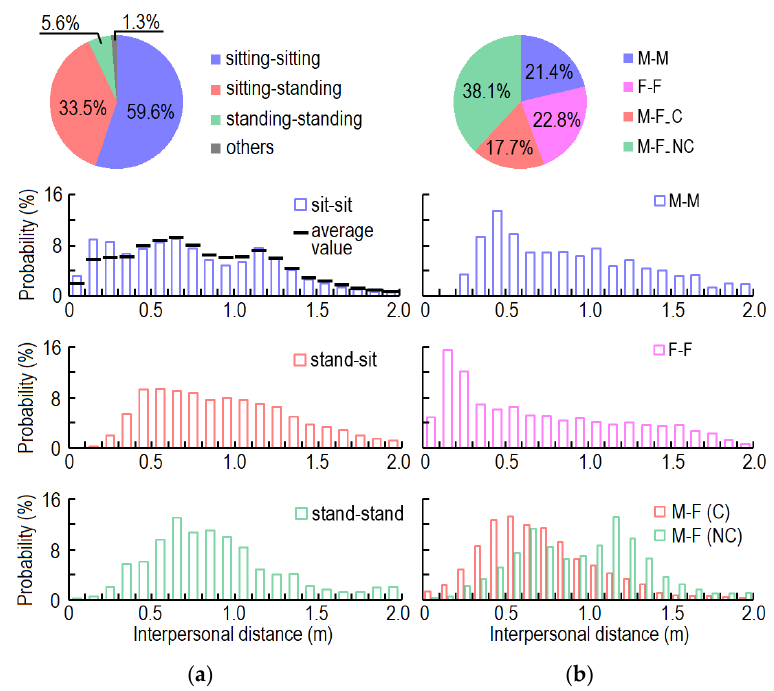
Figure 8. Probability distribution of interpersonal distance by: ( a ) Posture; ( b ) Gender.